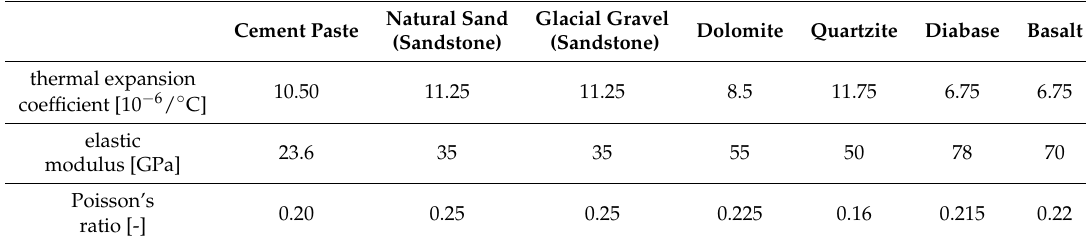
Table 7. Input for model predictions of the experiments by Naik et al. [37]: thermal expansion coefficients and elastic parameters of the cement paste, the fine aggregates and the coarse aggregates.